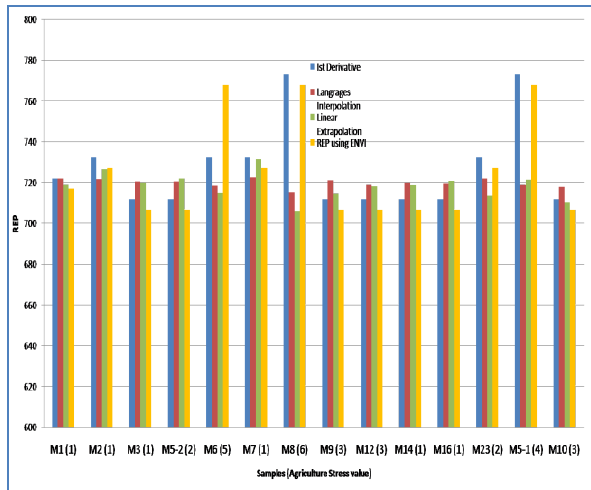
Figure 8: Comparison of REP for mulberry plants using all